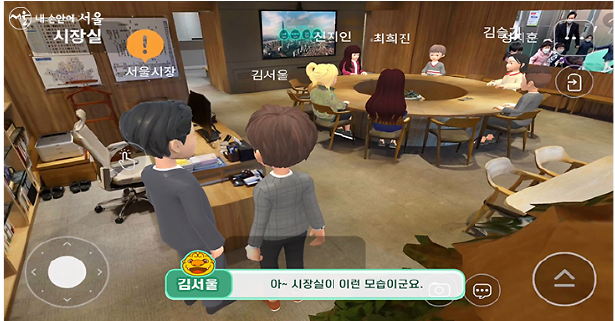
Figure 3: Metaverse Seoul, South Korea: Mayor’s office in the metaverse